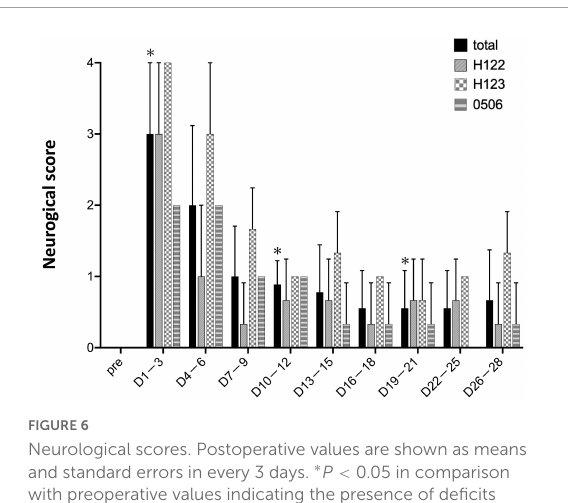
FIGURE6 Neurological scores. Postoperative values are shown as means and standard errors in every 3 days. ∗ P < 0.05 in comparison with preoperative values indicating the presence of deficits (paired t